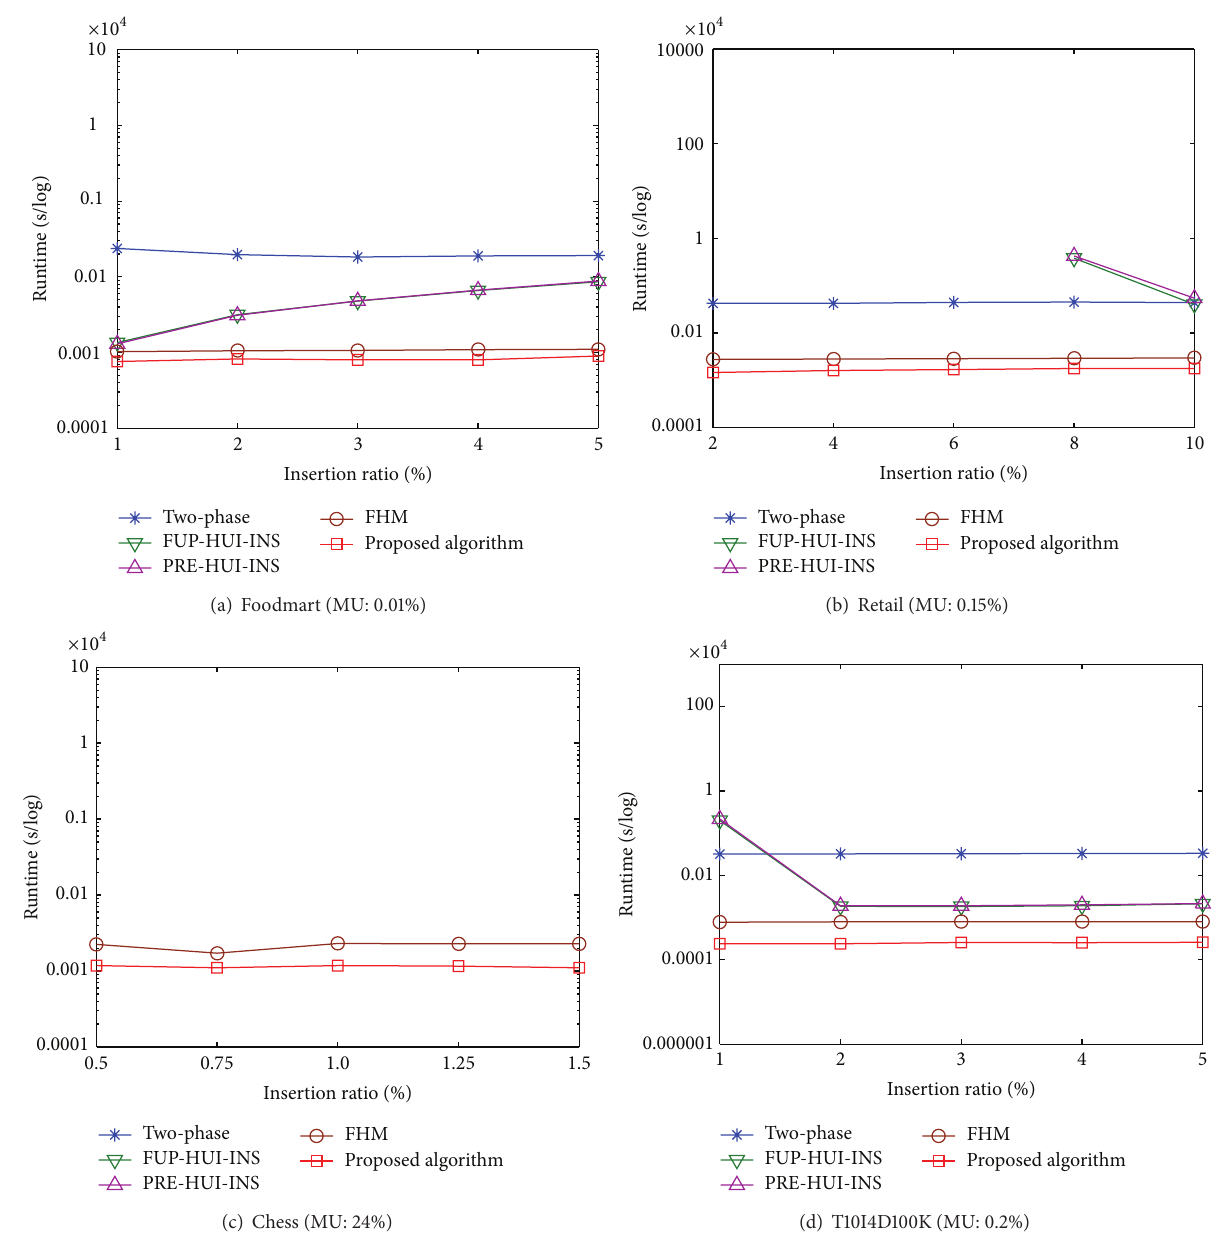
Figure 7: Runtime under various insertion ratios.